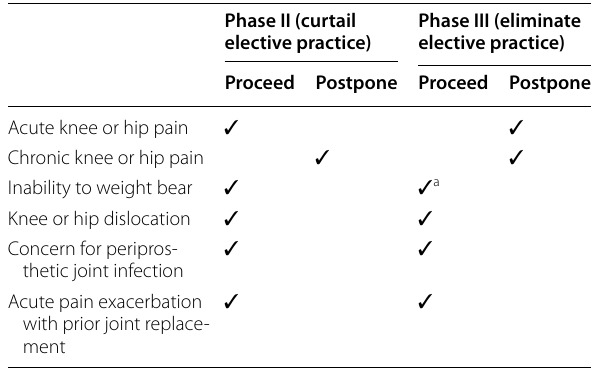
Table 3 US arthroplasty scheduling recommendations,